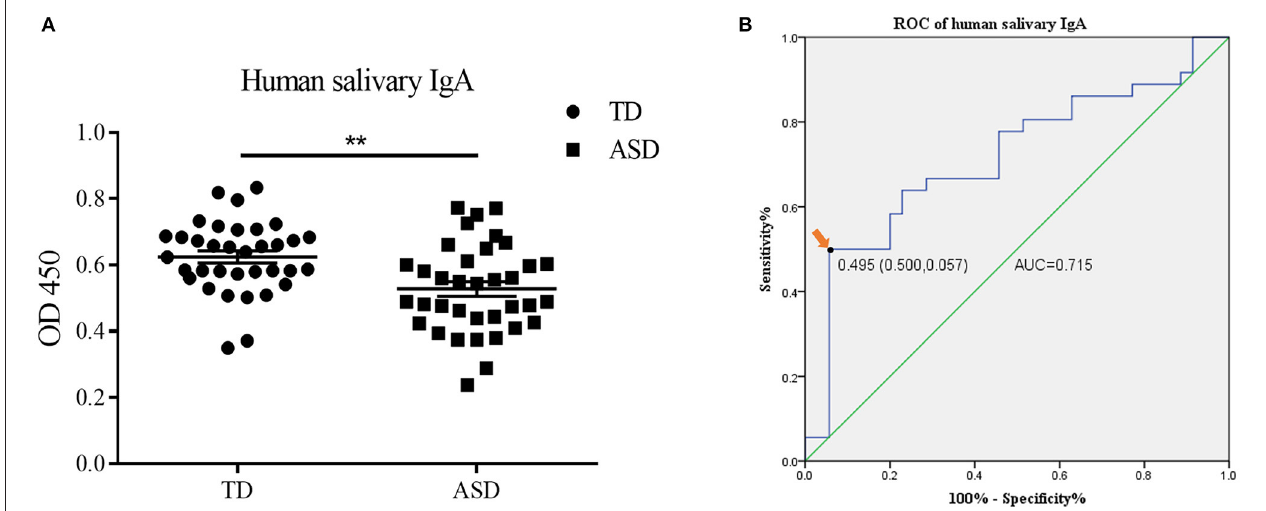
FIGURE 3 | The salivary immunoglobulin A (IgA) content in human saliva samples and the diagnostic value of human salivary IgA in Autism Spectrum Disorders (ASD). (A) The IgA content (presented as optical density at 450nm) in the saliva of the typically developing group and ASD children was determined by enzyme-linked immunosorbent assay. The above data are presented as the mean ± SEM, n = 35–36 per group, two replicate experiments, each data point represents results from an individual child, Student’s t -test, ** denotes p < 0.01. (B) The receiver operator characteristic (ROC) curve and the area under the ROC curve (AUC) of the salivary IgA in ASD diagnosis. The arrow indicates the optimal cutoff point of salivary